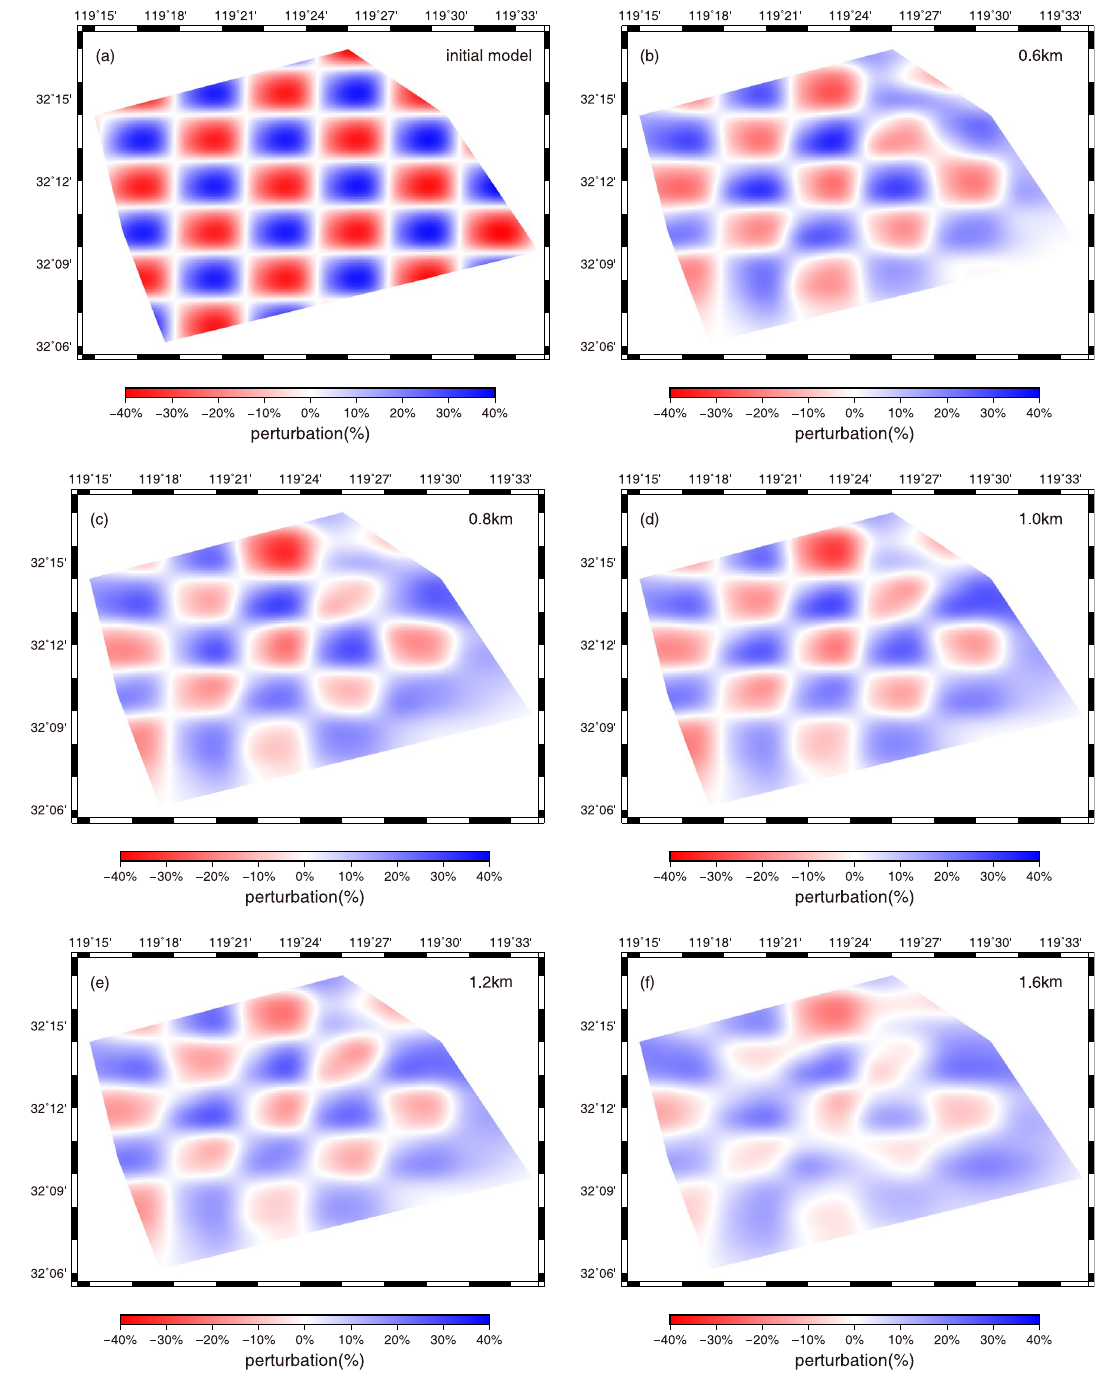
Figure 6. Checkerboard resolution tests of the inversion. a The initial checkerboard model and b-f the recovered checkerboard models at depths of 0.6, 0.8, 1.0, 1.2, and 1.6 km,